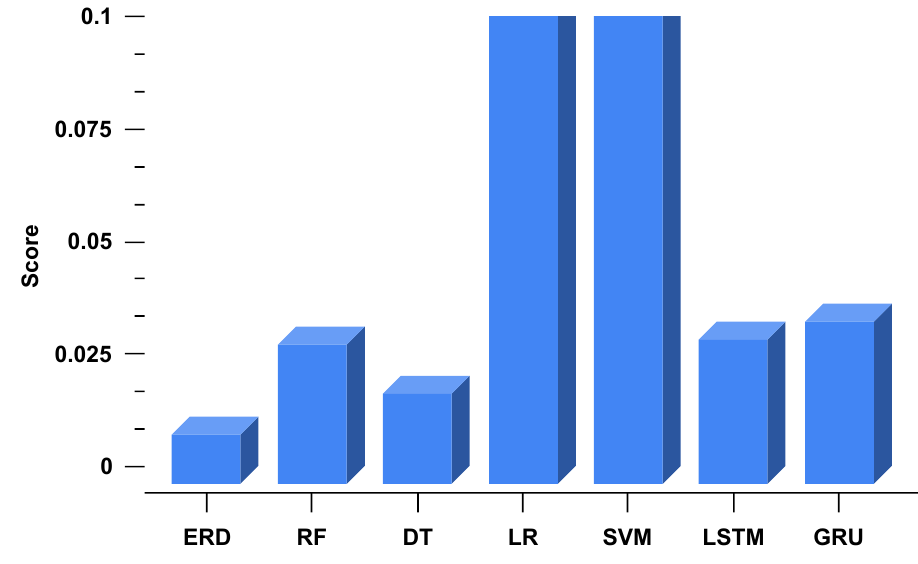
Figure 7. Error rate analysis of the applied machine learning and deep learning models. The time series-based performance analysis of the applied deep learning techniques during training is analyzed in Figure 8. The LSTM model analysis shows that a high loss score was achieved during the first training epoch, resulting in low accuracy scores. After the first epoch, the loss decreased, and the accuracy score increased. During the first epoch of the GRU model, the loss and accuracy scores were low, the same as in the LSTM model. Both deep learning techniques achieved good performance scores after the first training epoch. This analysis demonstrates that as the epochs increased, the performance of both deep learning models